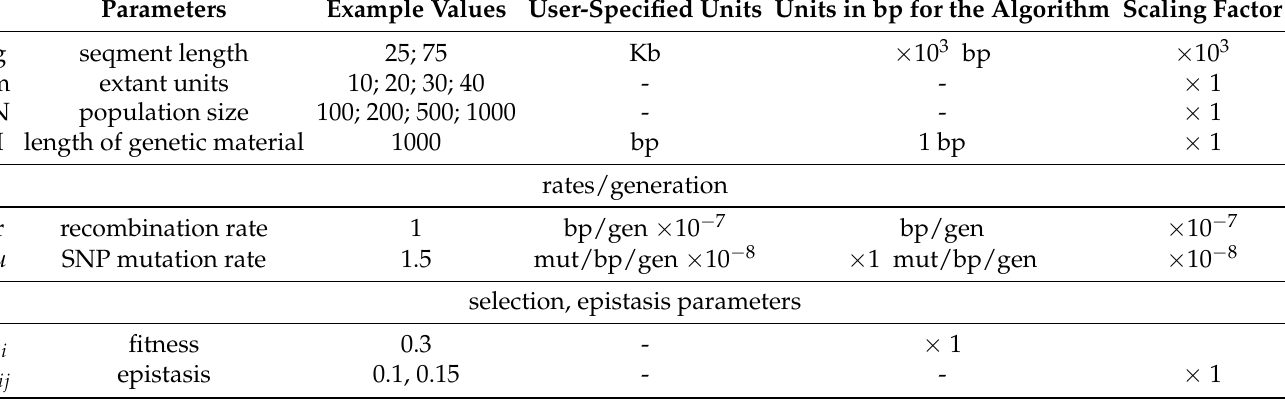
Table 1. Input parameters of the coalescent